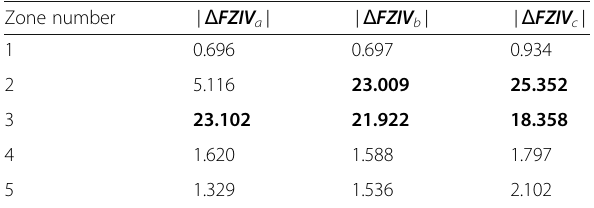
Table 5 Difference between FZIV preceding the fault and during the multiple simultaneous